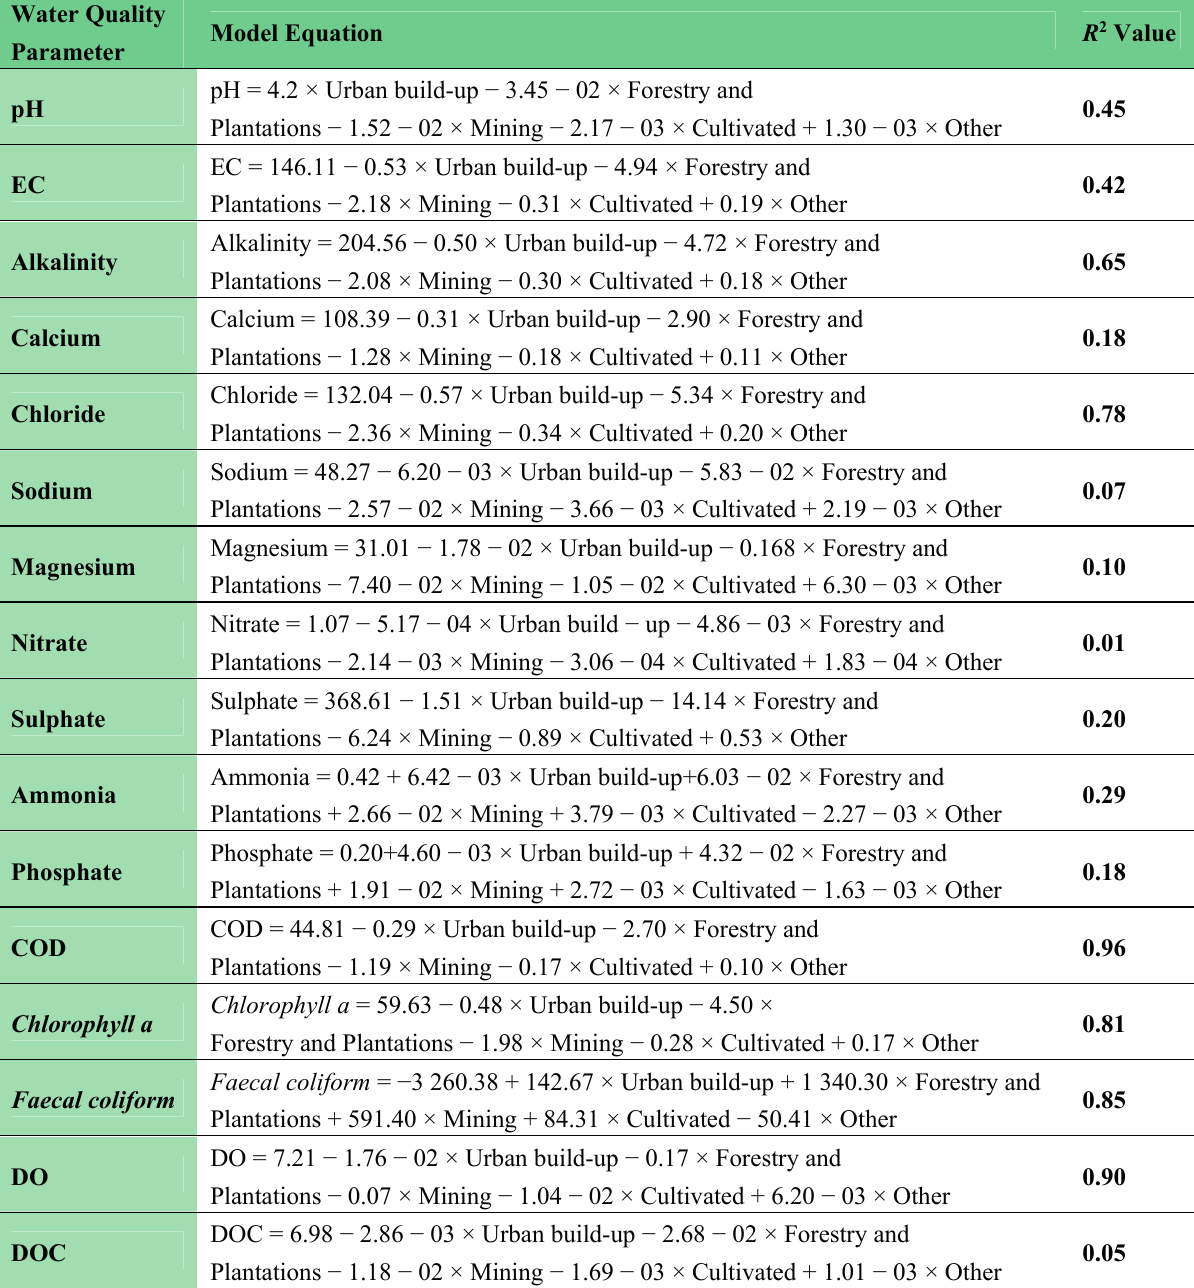
Table 4. Model equations and the respective adjusted R 2 values for each of the selected water quality parameters related to each land cover class 4 for the Blesbok Spruit